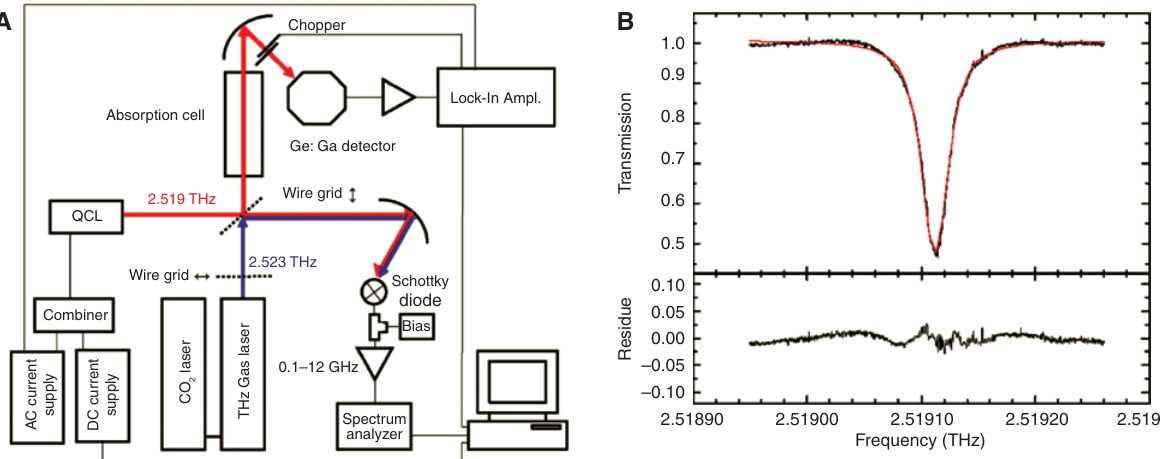
Figure 14: High-precision THz spectroscopy on methanol vapours with a QCL frequency referenced to a molecular transition. (A) Experimental setup and (B) acquired absorption spectrum measured at 100 Pa from [129], Copyright